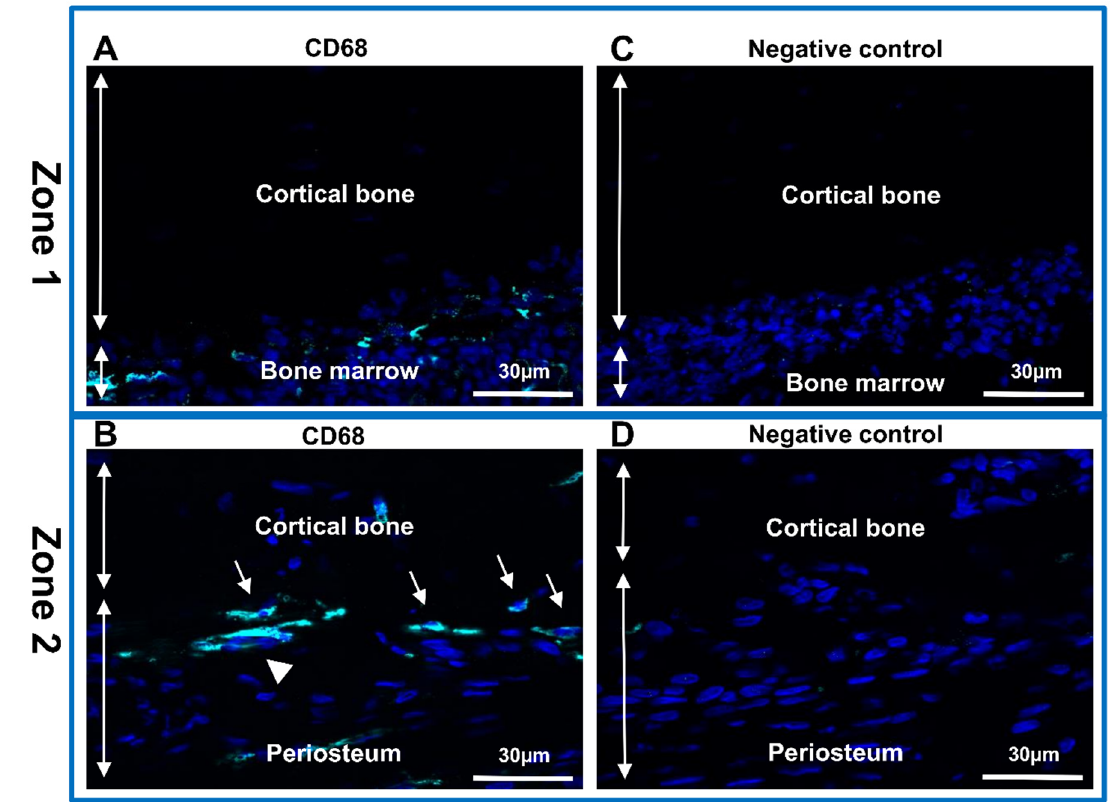
Figure 3. Identification of macrophages and osteoclast in rat femurs. Immunolabeling with anti-CD68 antibody in sections of two representative zones of the sample. ( A , C ) Zone 1-cortical bone and bone marrow; ( B , D ) Zone 2-periosteum and cortical bone. ( A , B ) Anti-CD68 (Alexa488, turquoise fluorescence), labeling the macrophages and osteoclasts. ( C , D ) Negative control. Nuclear staining with DAPI (blue fluorescence). Thin arrow: macrophages; arrowhead: osteoclast.